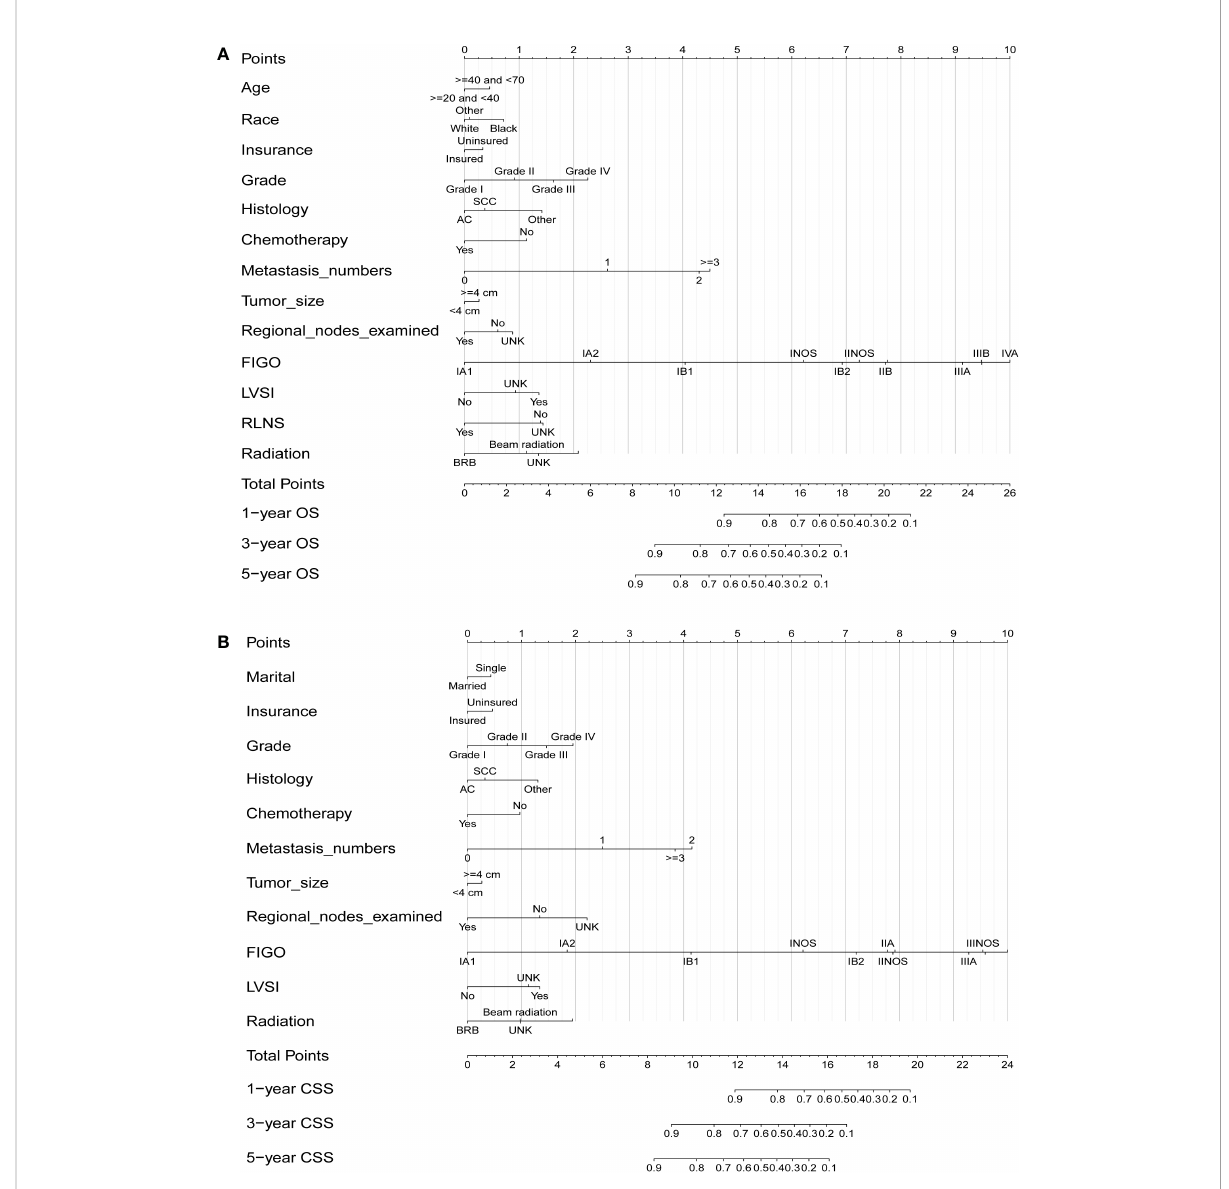
FIGURE 1 Nomograms for predicting 1-, 3-, and 5-year OS (A) and CSS (B) in patients with cervical